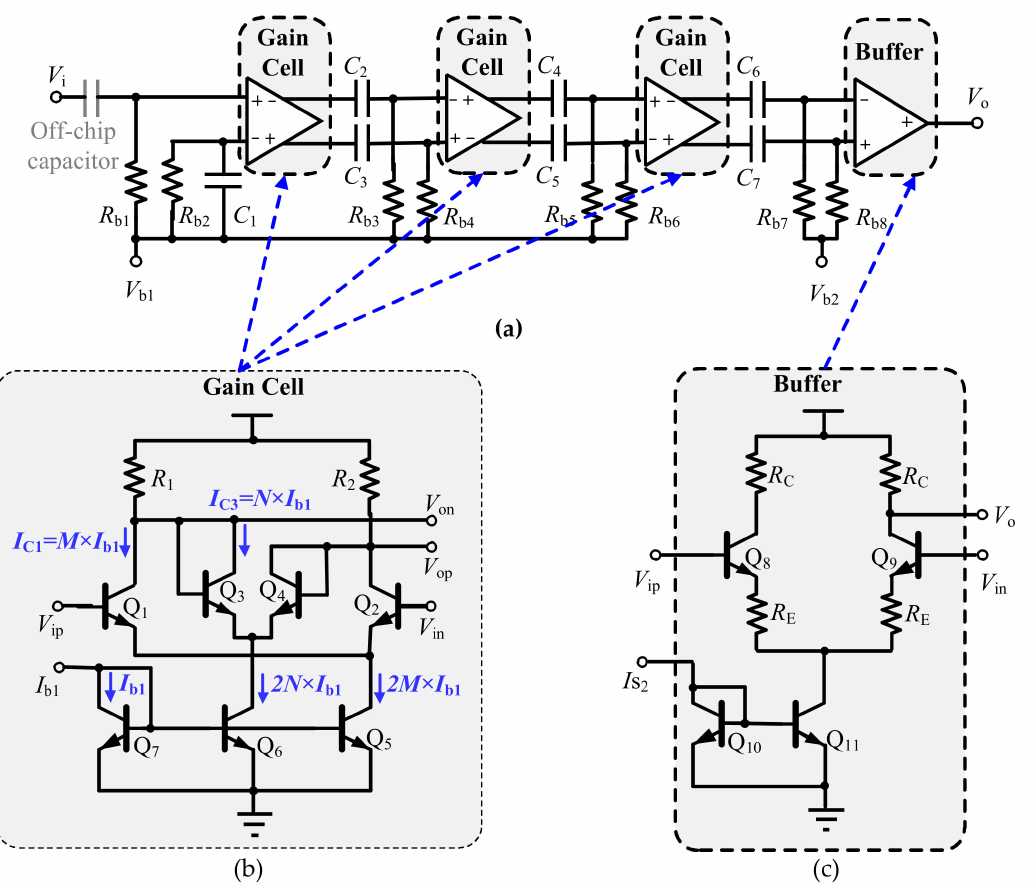
Figure 5. The proposed 4-stage cryogenic amplifier: ( a ) The amplifier topology; ( b ) Temperature- insensitive gain cell; ( c ) Output buffer